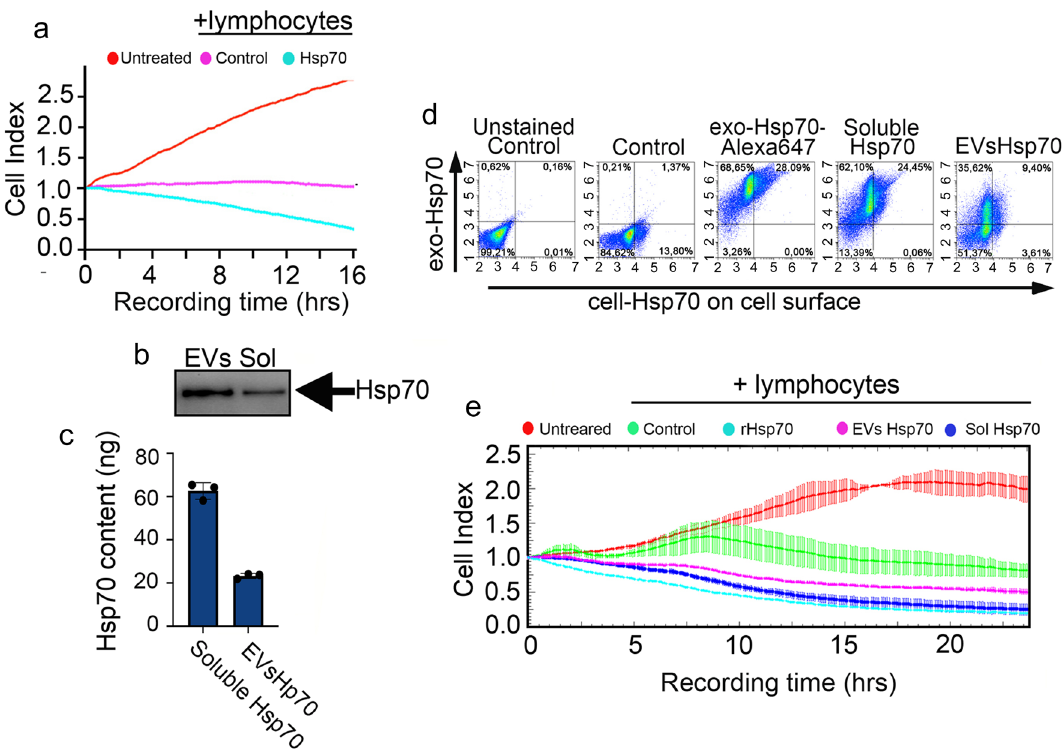
Figure 2. Both soluble Hsp70 and EVs Hsp70 pull out intracellular (endo) Hsp70 to the cell surface and sensitize B16 cells to cytotoxic lymphocytes. ( a ) B16 cells were incubated with rHsp70 for 6 h and were subjected to the CTL test with lymphocytes from a healthy mouse. Cell death was recorded in real time with the aid of xCELLigence. ( b ) EVs and soluble fractions from B16 cells incubated with rHsp70 were collected and subjected to ( b ) Western blotting or ( c ) Hsp70-ELISA. Data from three independent experiments are presented. A full-length blot images used to generate the panel is shown in Suppl Fig. S5 ( d ) B16 cells were incubated with rHsp70-Alexa647, EVs Hsp70 and soluble Hsp70, and subjected to flow cytometry. Representative data of three independent experiments is presented. ( e ) B16 cells were incubated with the soluble fraction or with EVs- Hsp70 for 3 h and lymphocytes of an untreated mouse were added. rHsp70 (50 μg/mL) was used as a positive control. The CTL assay was employed with the aid of xCELLigence. Representative data of three independent experiments is